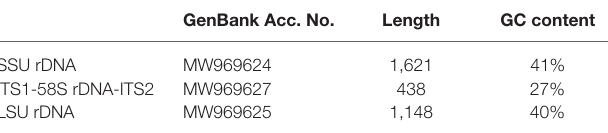
TABLE 3 | Sequence information of Campanella sinica n.